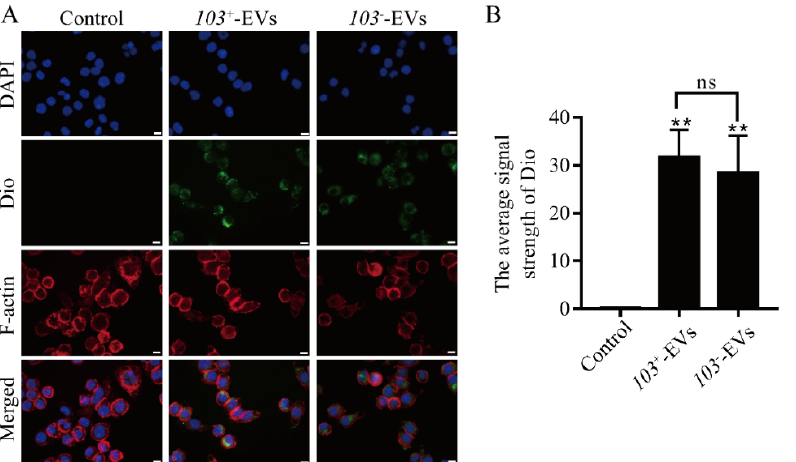
Figure 2. 103 + ‐ EVs and 103 − ‐ EVs are internalized by J774A.1 cells. ( A ) Representative confocal im ‐ ages of J774A.1 cells exposed to 103 + ‐ EVs or 103 − ‐ EVs for the indicated times. Green, Dio ‐ stained 103 + ‐ EVs or 103 − ‐ EVs; Red, F ‐ actin; blue, DAPI nuclear stain. The control group consisted of J774A.1 cells treated with Dio ‐ PBS. Scale bars: 20 μ m. ( B ) The average signal strength of Dio ‐ labled 103 + ‐ EVs or 103 − ‐ EVs uptake by J774A.1 cells. The data were compared with the Dio ‐ labled PBS stimulated control cells. The comparisons between groups were performed by one ‐ way ANOVA followed by Tukey’s test. ** p < 0.01, and ns, not significant.